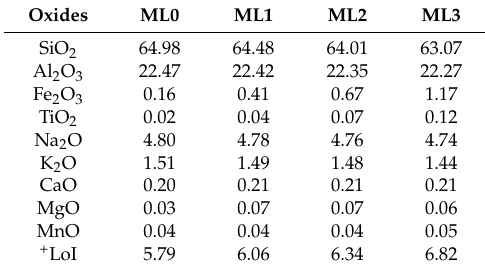
Table 4. Chemical compositions of the floor tile formulations (wt.